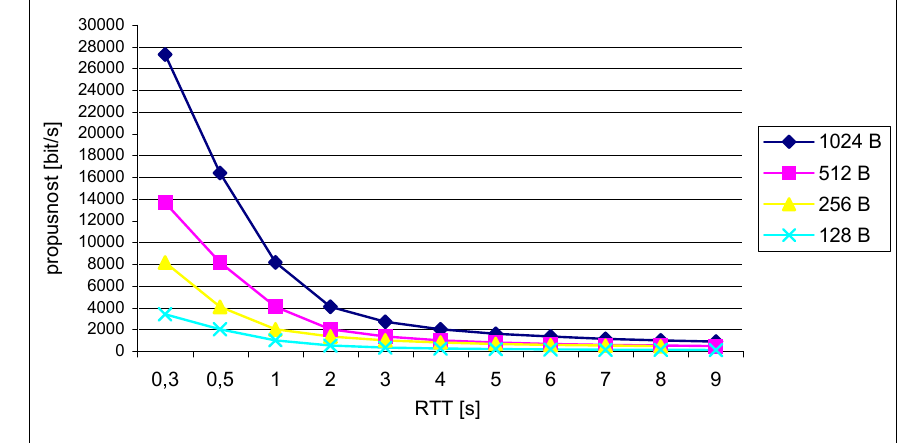
Figure 1 – Presentation of the dependence of the throughput of the TCP versus the round trip time, RTT Slede ć a analiza odnosi se na situaciju kada se u toku prenosa podata- ka na paketima javljaju greške. Tada se TCP propusnost redukuje i